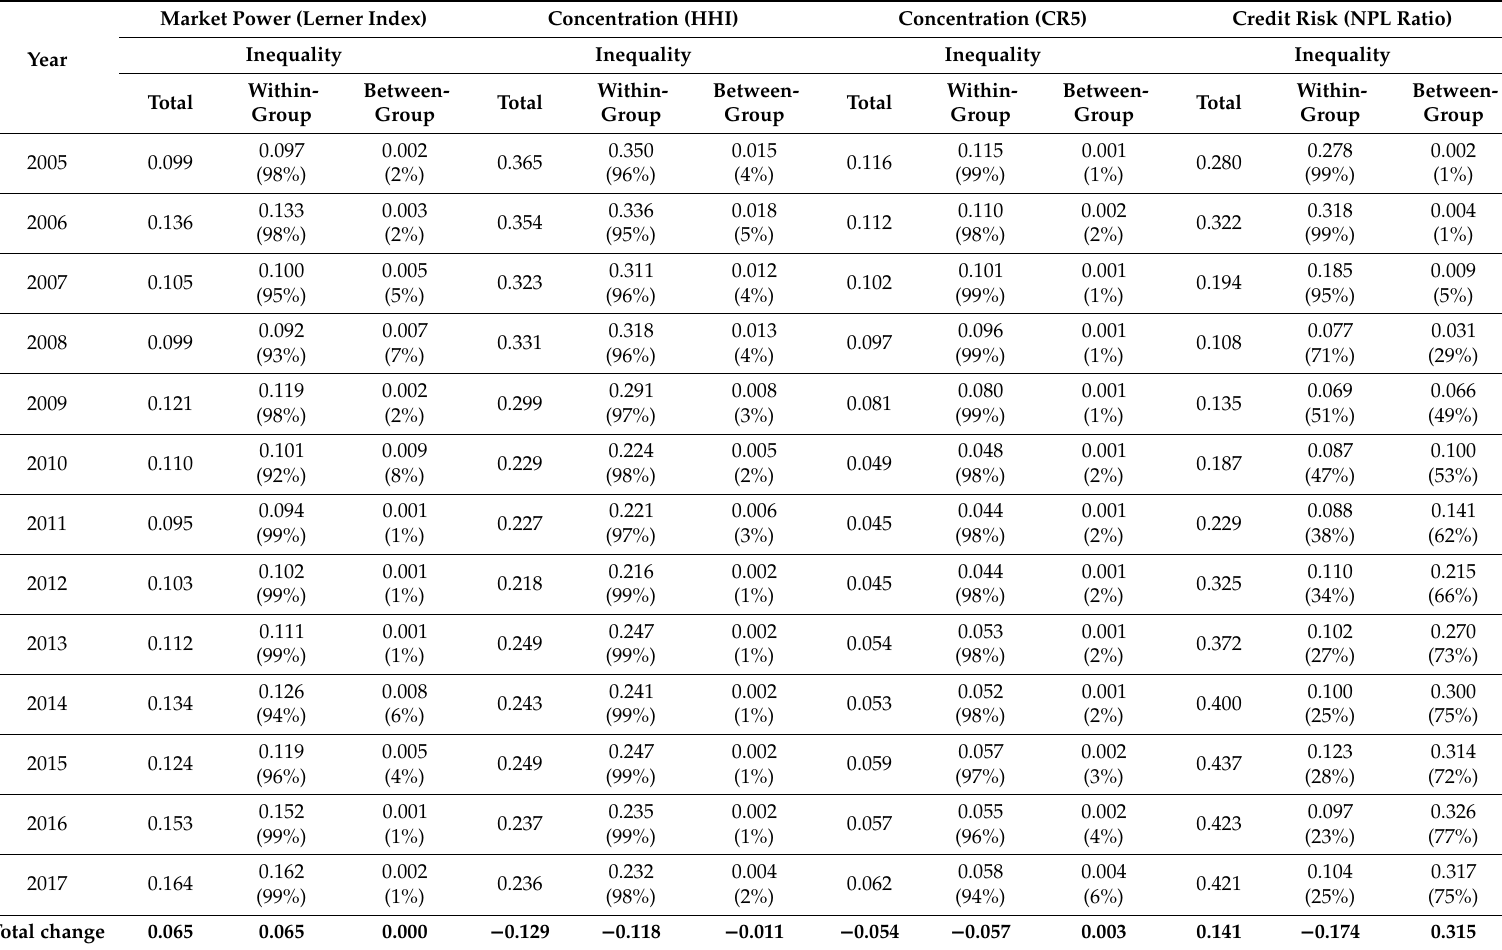
Table 5. Evolution and decomposition of the Theil inequality index for the euro area core and periphery country groups into within-group and between-group